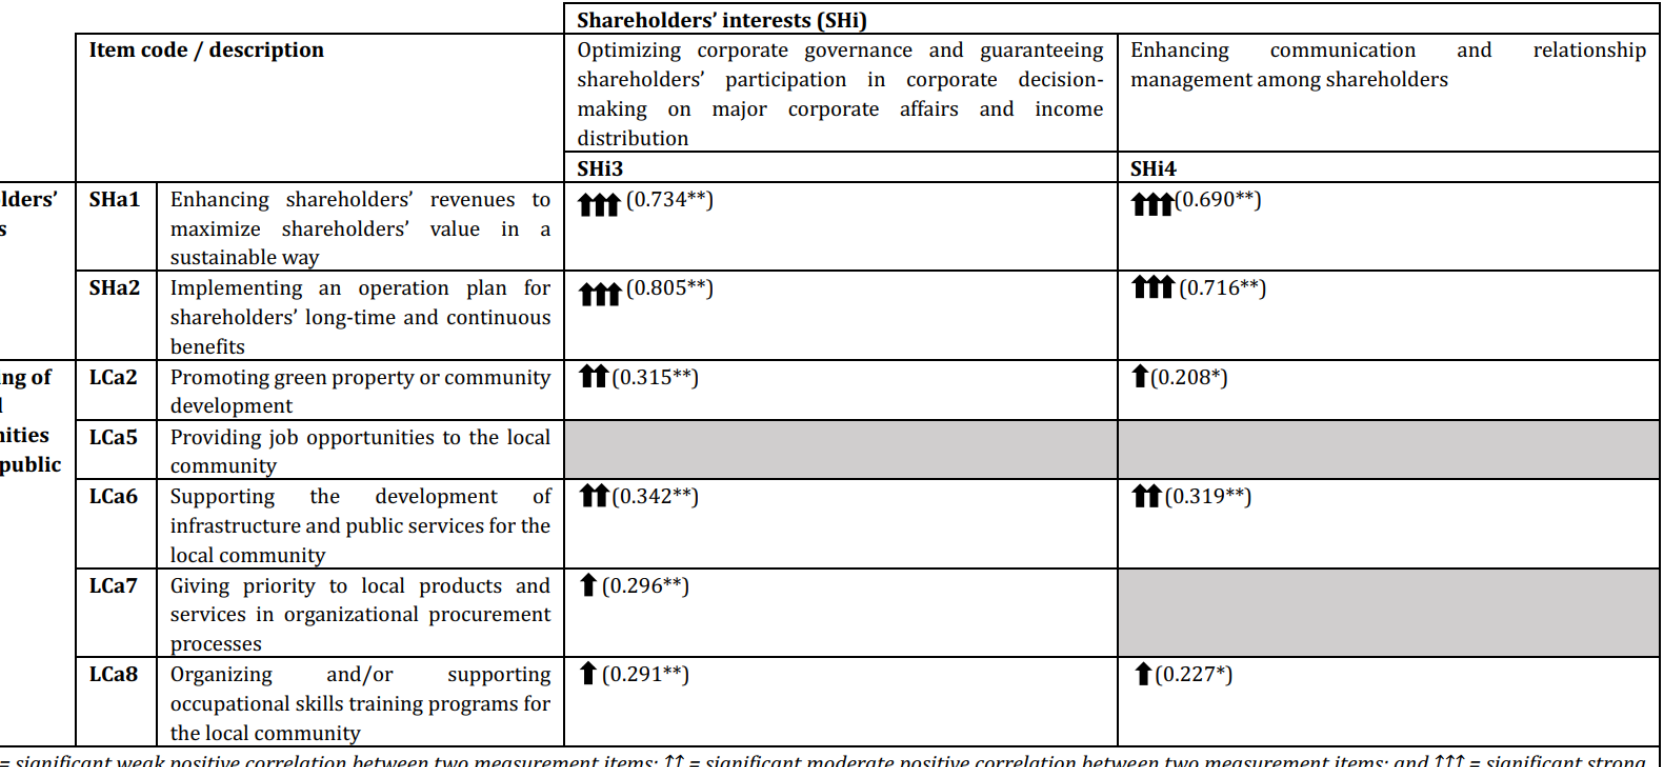
Figure 4. Relationship guide 1 for checklists of corporate social responsibility I implementation.